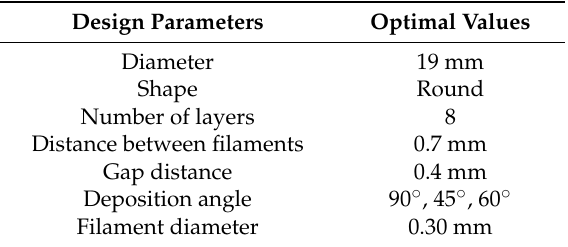
Table 2. Design parameters and the corresponding optimized